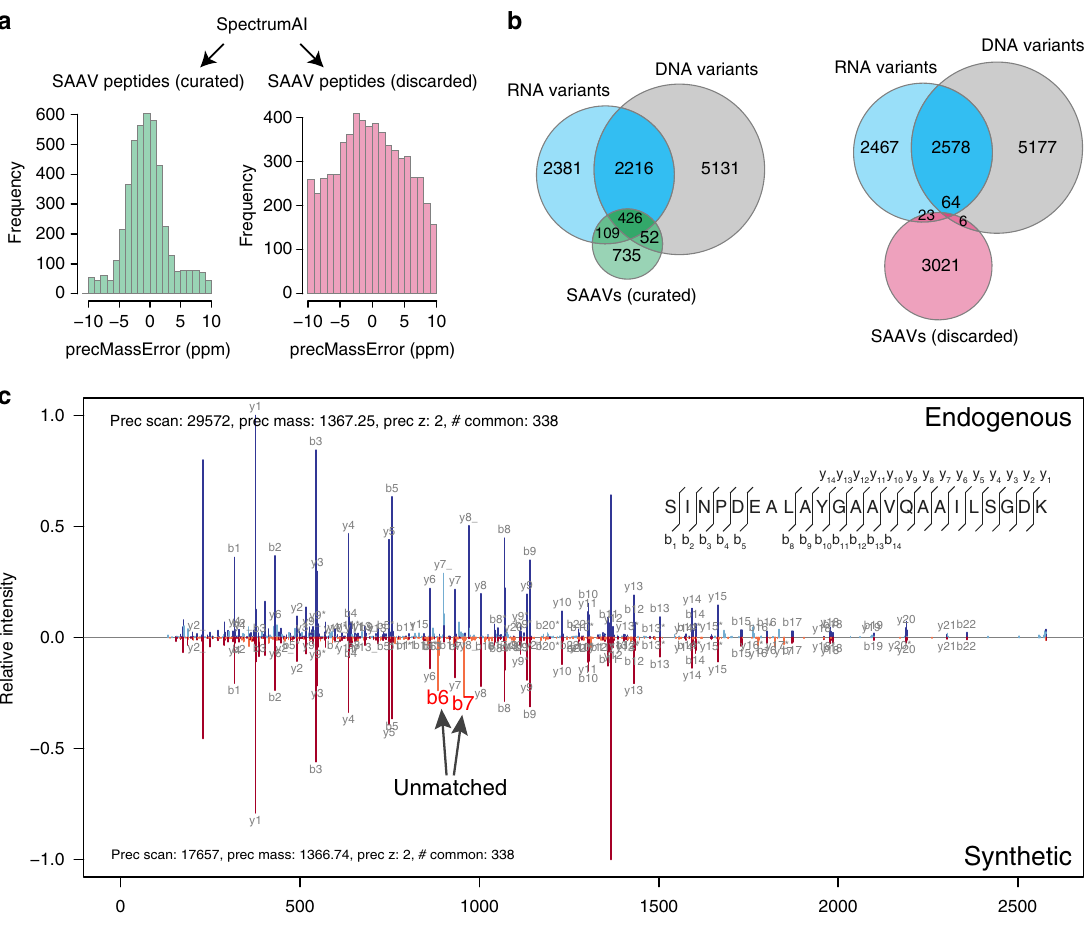
Fig. 3 SpectrumAI increases identi fi cation accuracy of peptides with single amino acid changes. a Precursor mass error distributions of peptides classi fi ed as curated and discarded by SpectrumAI. b Curated SAAV peptides have more overlap with missense variants identi fi ed at DNA and RNA level. c Mirror plot of an incorrectly identi fi ed peptide (that yet had passed discovery stage with class-speci fi c FDR 1%) with a single residue substitution (V > L, at position 8) that was subsequently discarded by SpectrumAI. Annotated MS2 spectrum of the endogenous peptide is shown on top, whereas that of the respective synthetic peptide is inverted and shown on bottom. This incorrect peptide identi fi cation detected by SpectrumAI shows mismatching b6 and b7 product ions (highlighted in the synthetic side and missing in the endogenous side), which ought to have fl anked the substituted residue, indicating that the endogenous amino acid sequence is incorrect between its sixth and eighth